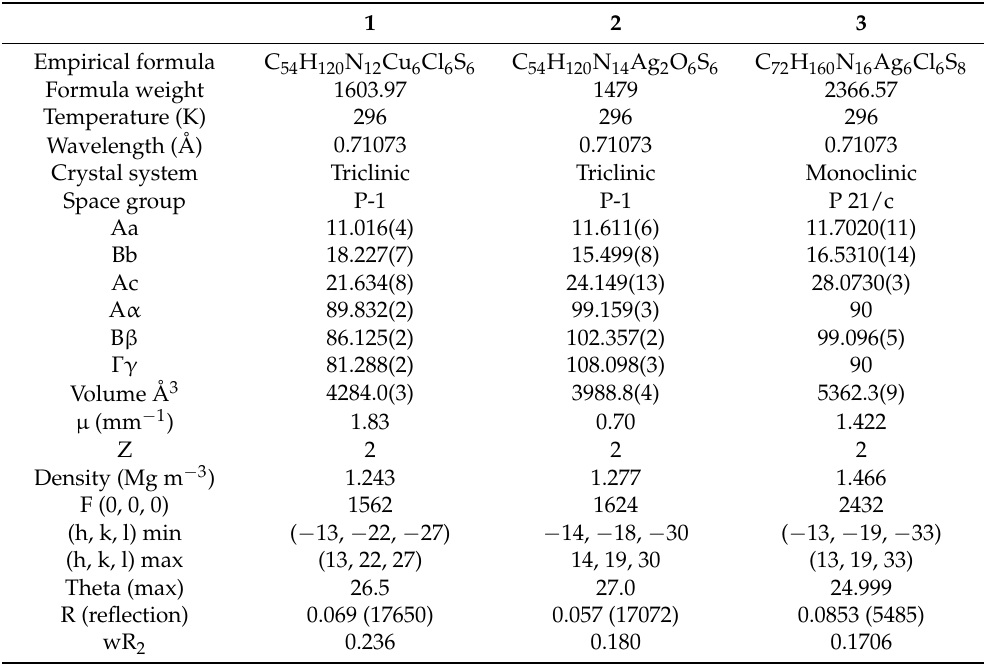
Table 2. Crystal structure determination and structure refinements of compound 1 – 3 .